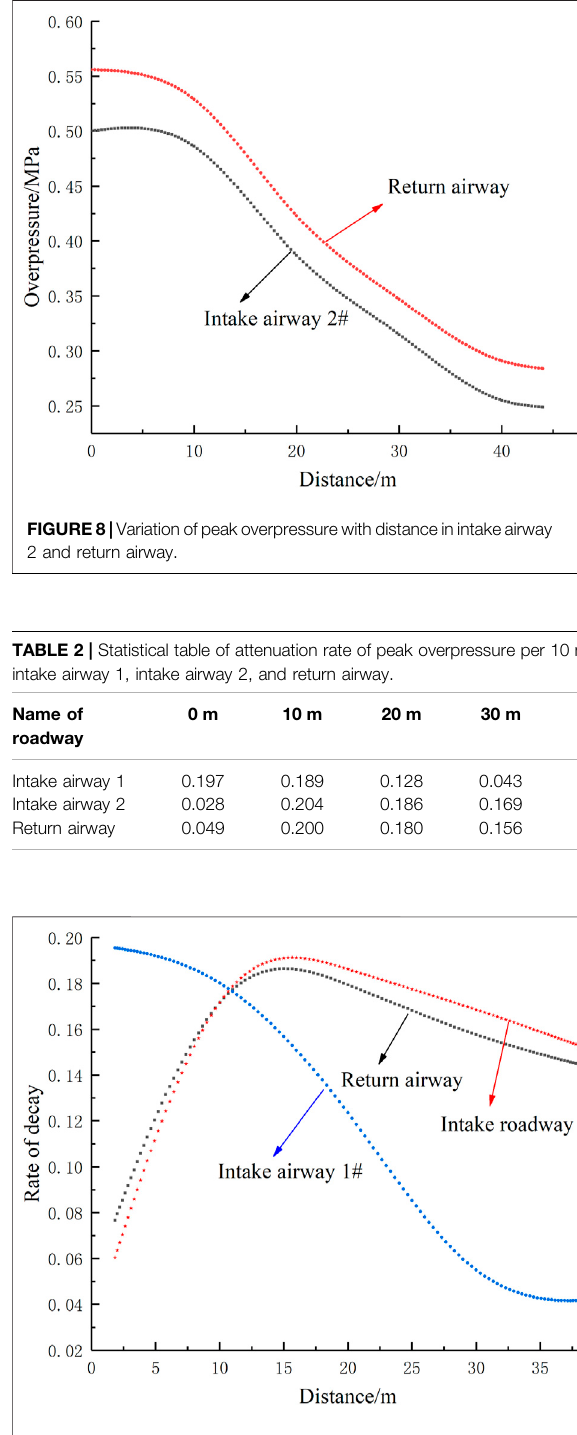
FIGURE 9 | Variation rule of attenuation rate of peak overpressure per 10-m intake airway 1, intake airway 2, and return